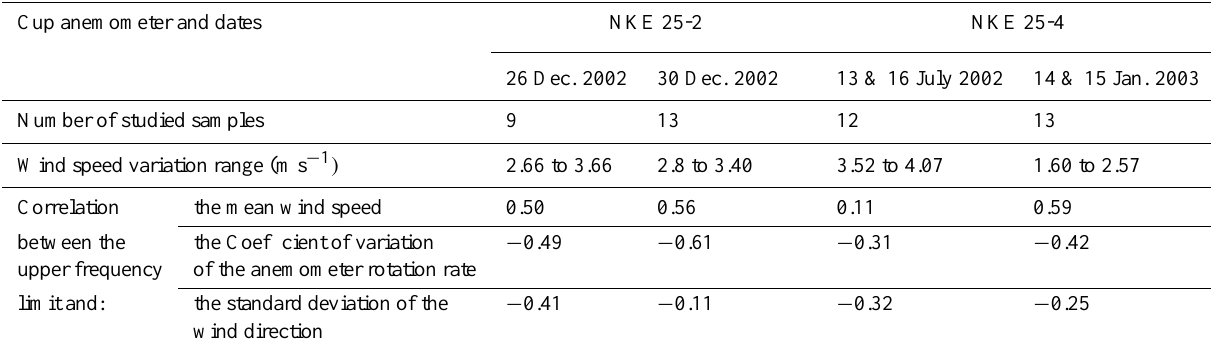
Table 3. Correlation between, on the one hand, the upper frequency limit and, on the other hand, the mean wind speed, the standard deviation of the wind direction and the coefficient of variation of the cup anemometer rotation rate.